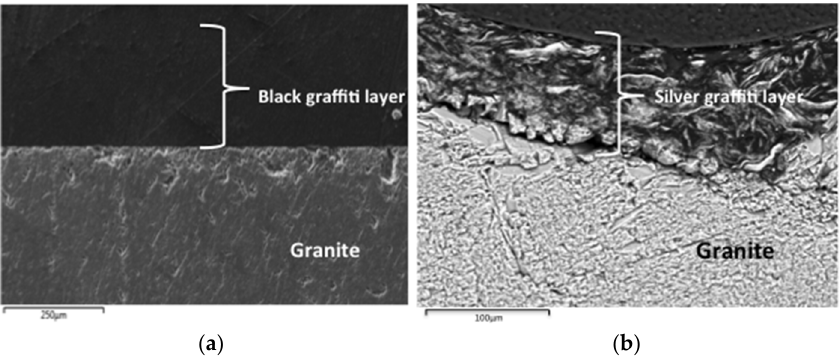
Figure 2. Cross ‐ section micrographs of the granite surfaces painted obtained by SEM. ( a ) painted with the black graffiti paint (GNB); ( b ) painted with the silver graffiti paint (GPB). The sample codes are shown in Table 1.